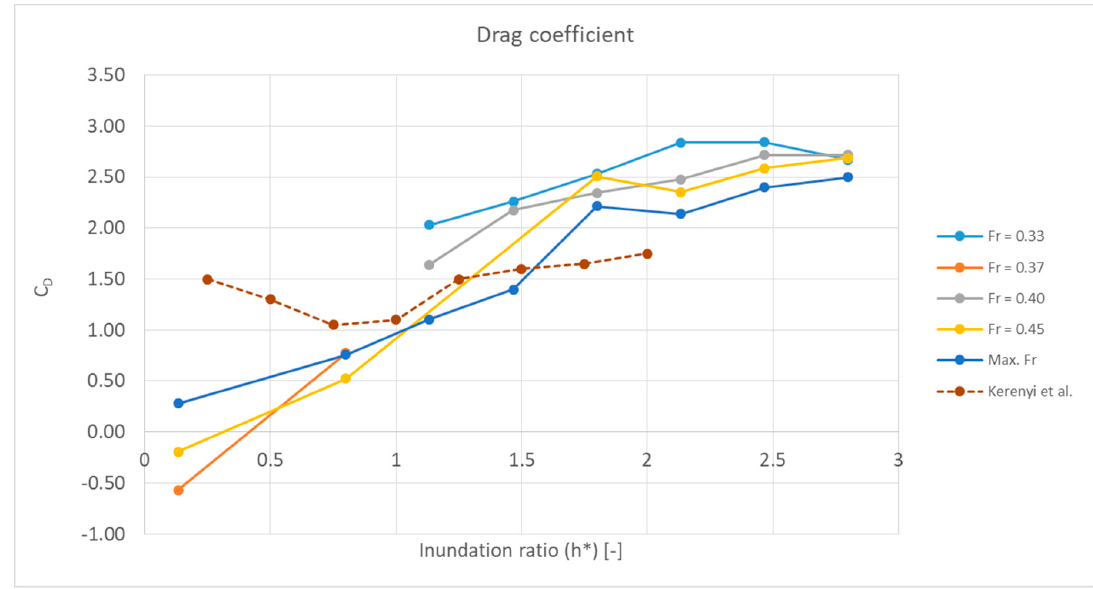
Figure 11. Drag coefficients measured with the load cell, compared with those of the three girder deck of Kerenyi et al. [6]. The dashed line corresponds to the values of Kerenyi et al. [6]. Note that C D values at h* = 0.13 are based on forces close to the resolution limit of the load cell.